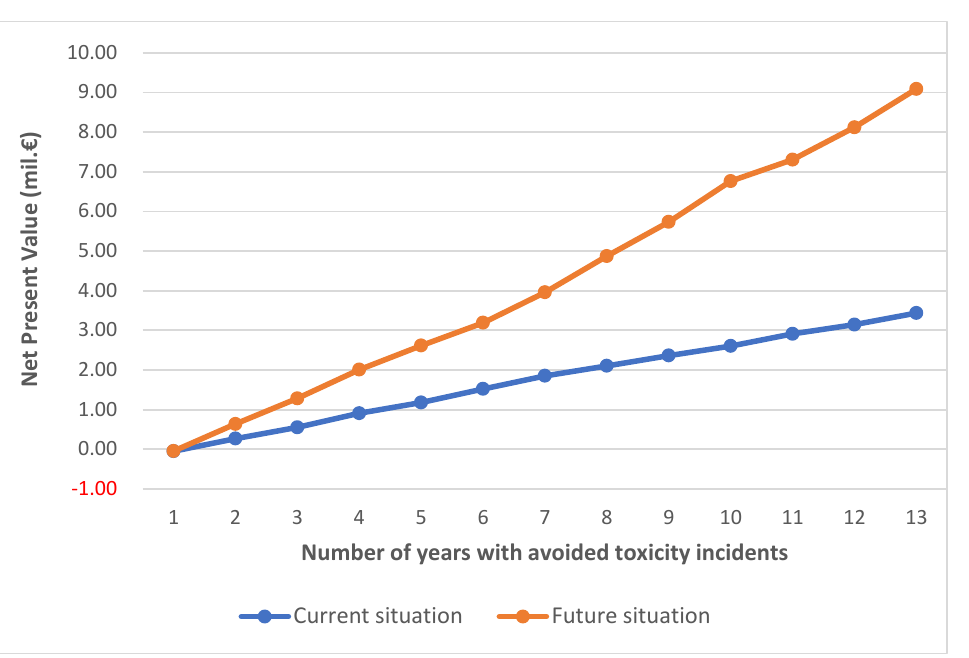
Figure 2. NPV of the investment on the installation of the SmartMussel system under different number of years of toxicity incident avoidance.